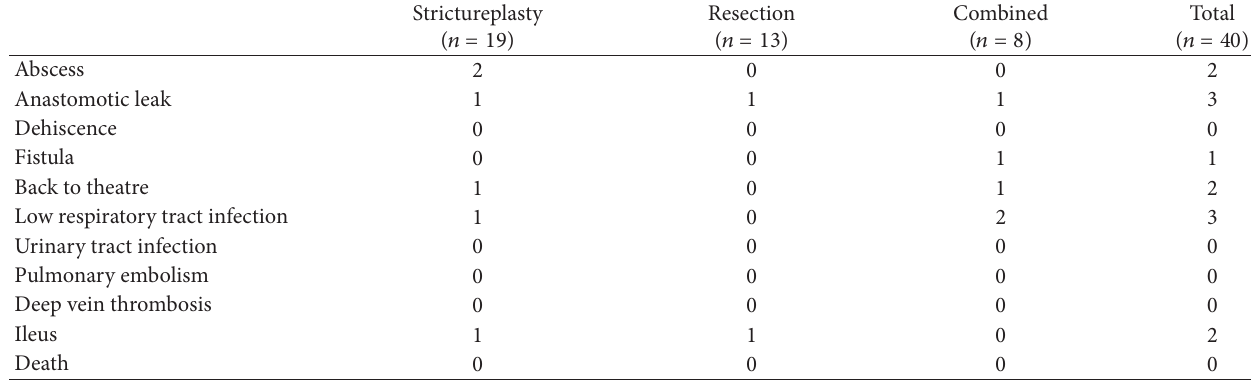
Table 1: Complications of patients undergoing surgical intervention.